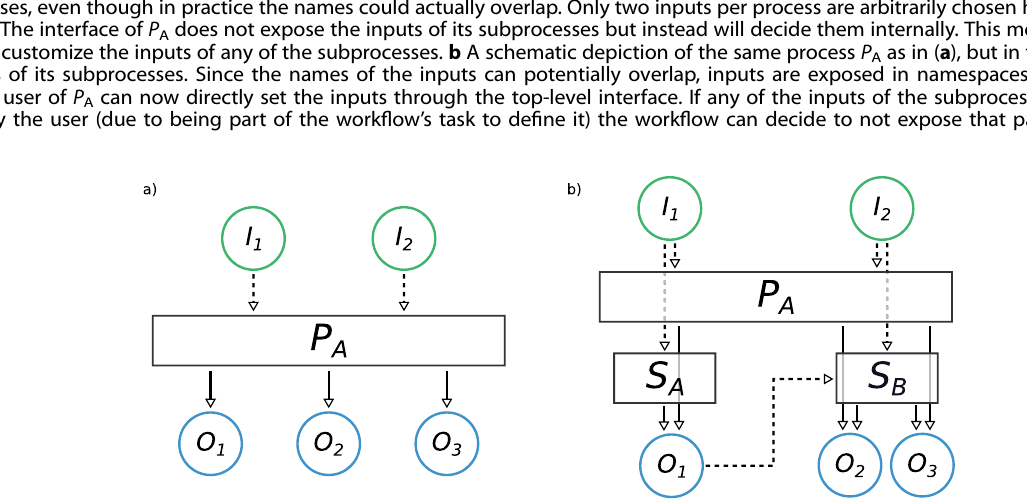
Fig. 2 Scope provenance. a Schematic provenance of a work fl ow ( P A ) that takes two inputs ( I 1 and I 2 ) and produces three outputs ( O 1 , O 2 , O 3 ). b A more detailed view of the complete provenance of P A , which actually runs two subprocesses ( S A and S B ). Input I 1 is passed by P A to S A , which results in O 1 . This intermediate output O 1 is passed by P A to S B as an input, in addition to I 2 , which results in the outputs O 2 and O 3 . The latter are returned by P A as the fi nal outputs together with the O 1 intermediate result.